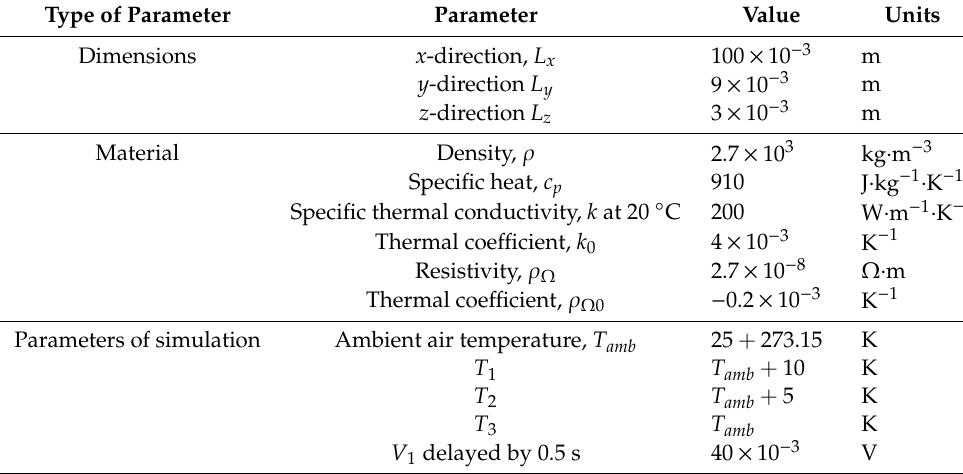
Table 2. Parameters used in the simulation.